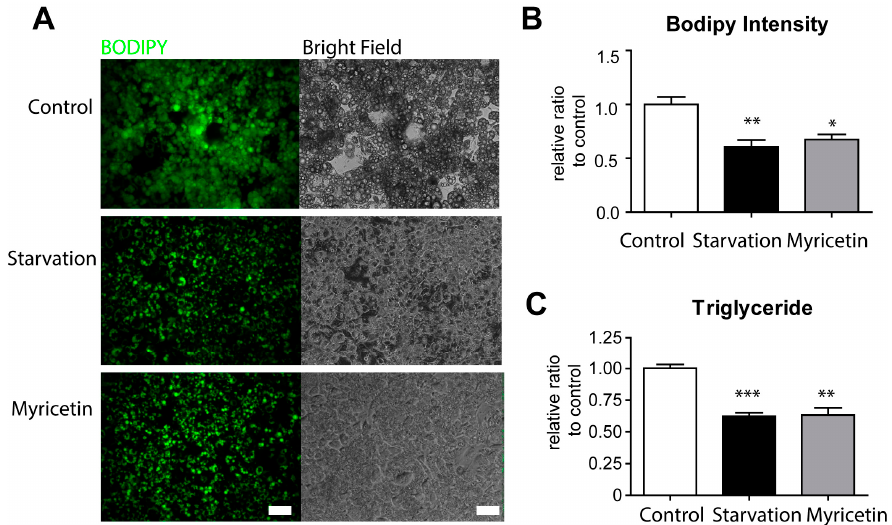
Figure 1. Effects of myricetin on lipid content in adipocytes differentiated from C3H10T1/2 cells. ( A ) Boron dipyrromethene fluorophore (BODIPY) staining in adipocytes differentiated from C3H10T1/2 cells treated with myricetin (10 μ M) for 24 h. Nutrient starvation medium (starvation) was used as positive controls. Size bar = 40 μ m ( B ) Quantification of BODIPY intensity of ( A ). ( C ) Intracellular triglyceride (TG) levels. ( n = 3, means ± SEM, * p < 0.05, ** p < 0.01, *** p < 0.001)